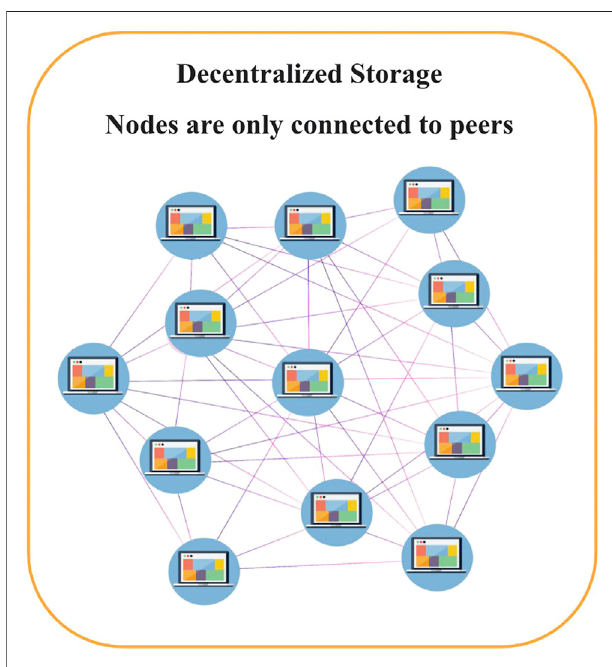
FIGURE 3 | Decentralized